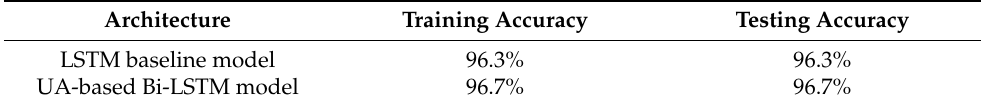
Table 8. Accuracy metrics by implementing a raw signals-based database as inputs in